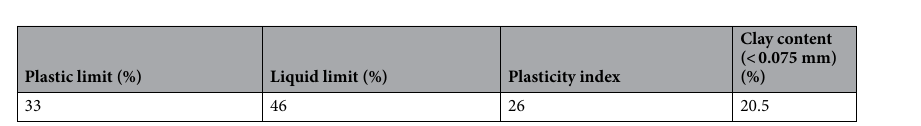
Table 1. The Liquid-plastic limit test and particle size analysis result of the special